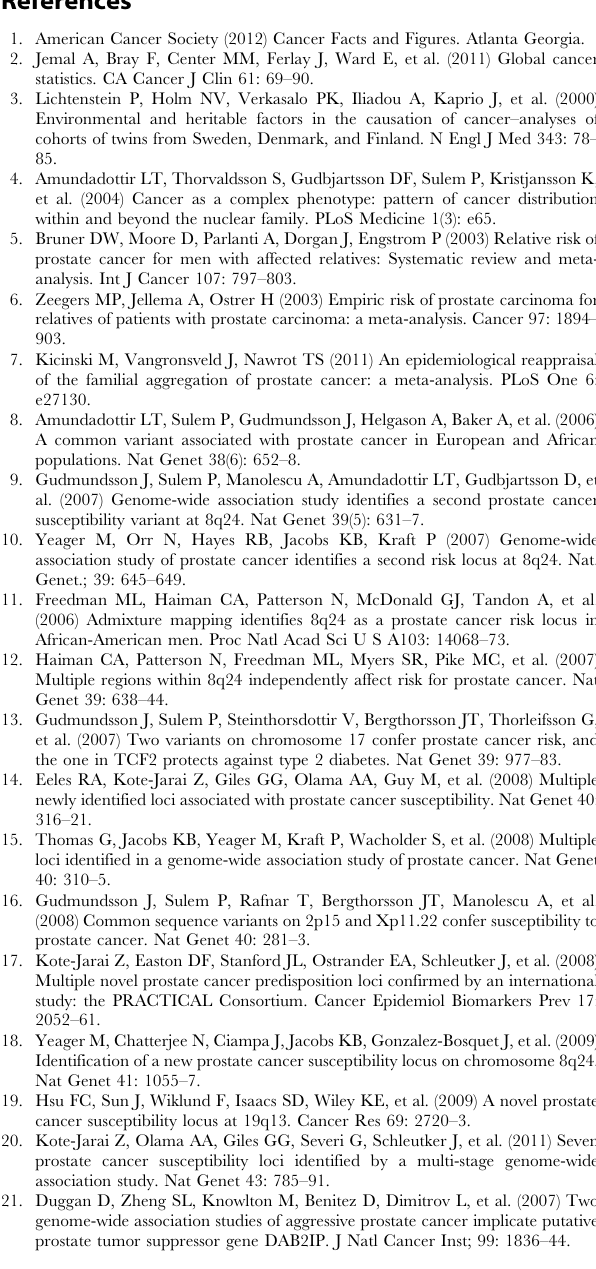
Table S1 Selected characteristics of Ashkenazi Jewish prostate cancer cases and controls. Table S2 Associations of GWAS SNPs with Overall Risk of Prostate Cancer among Ashkenazic Men (Genotype Risk Models). Table S3 Associations of GWAS SNPs with Young Onset Prostate Cancer. Table S4 Associations of GWAS SNPs with Risk of Prostate Cancer stratified by Family History of Prostate Cancer and Other